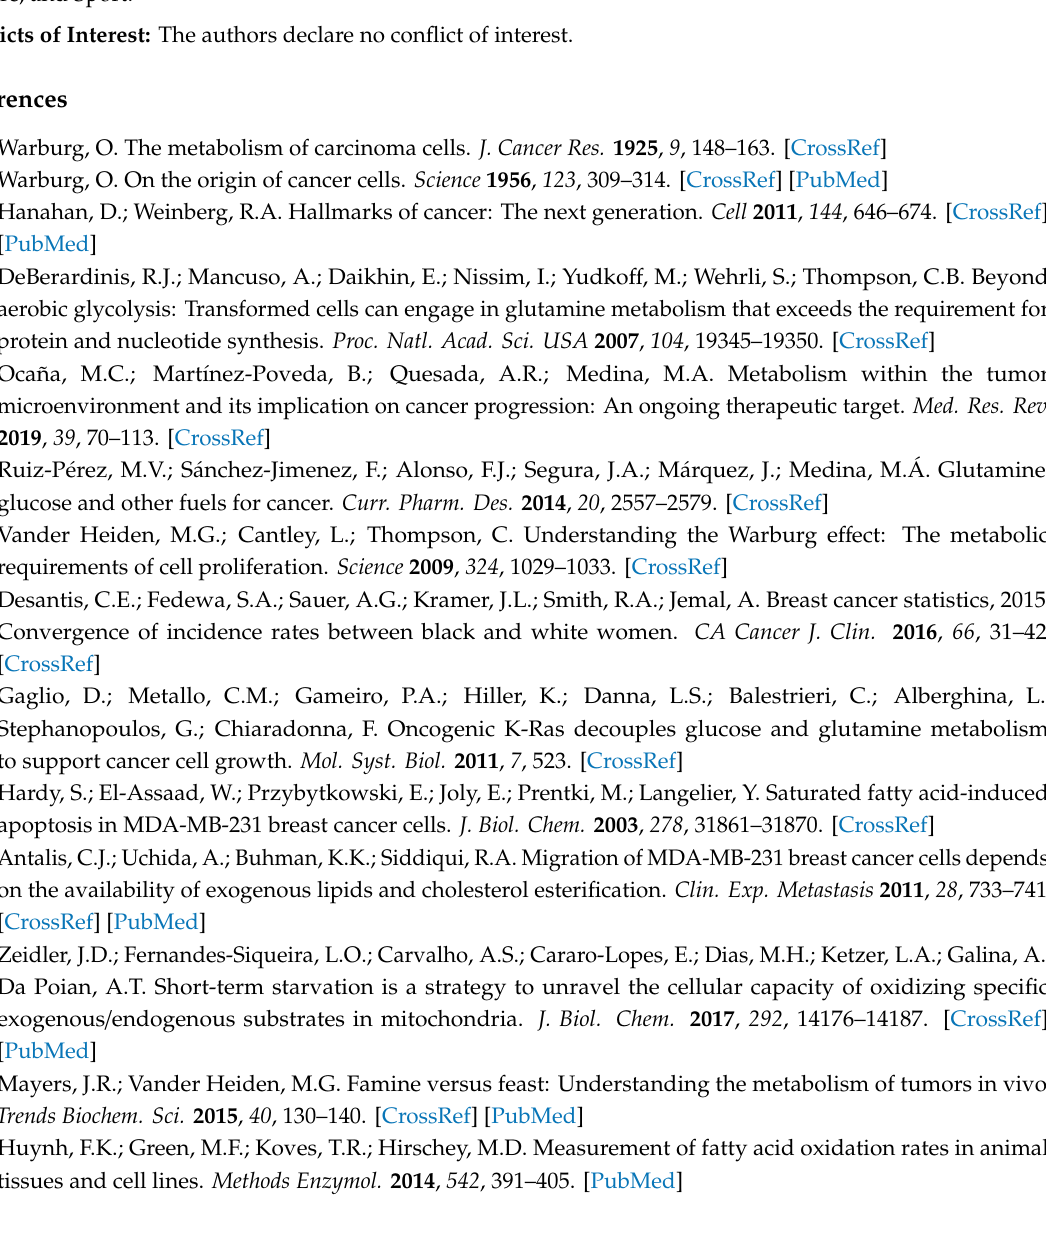
Figure S1: E ff ect of long-time exposure of MDA-MB-231 cells to